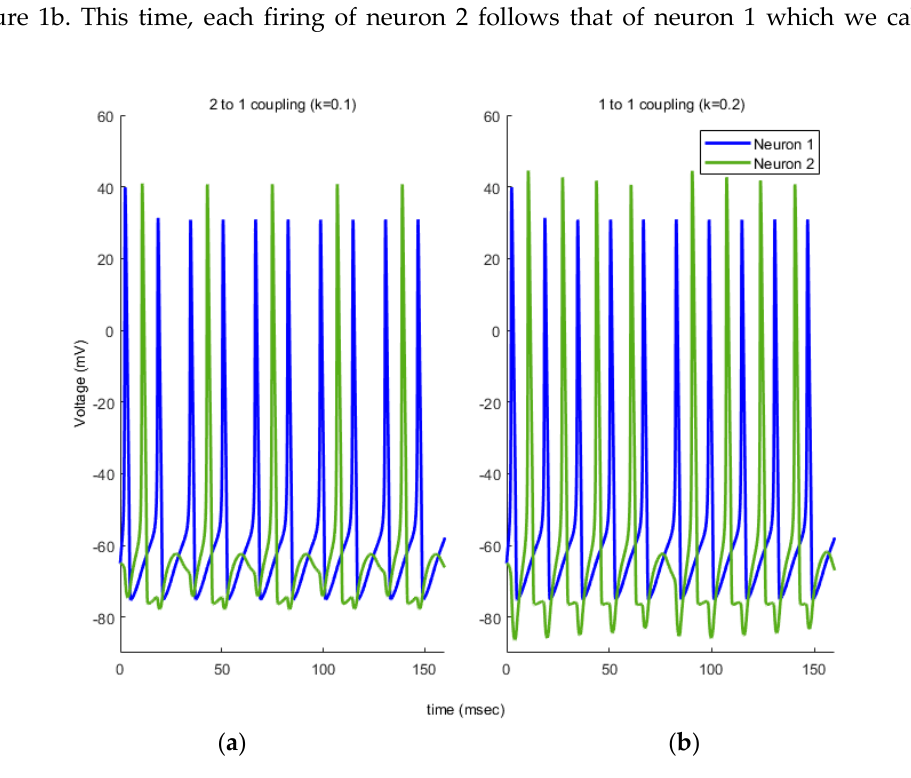
Figure 1. Sample spike patterns for two different network configurations: ( a ) 2 to 1 coupling and ( b ) 1 to 1